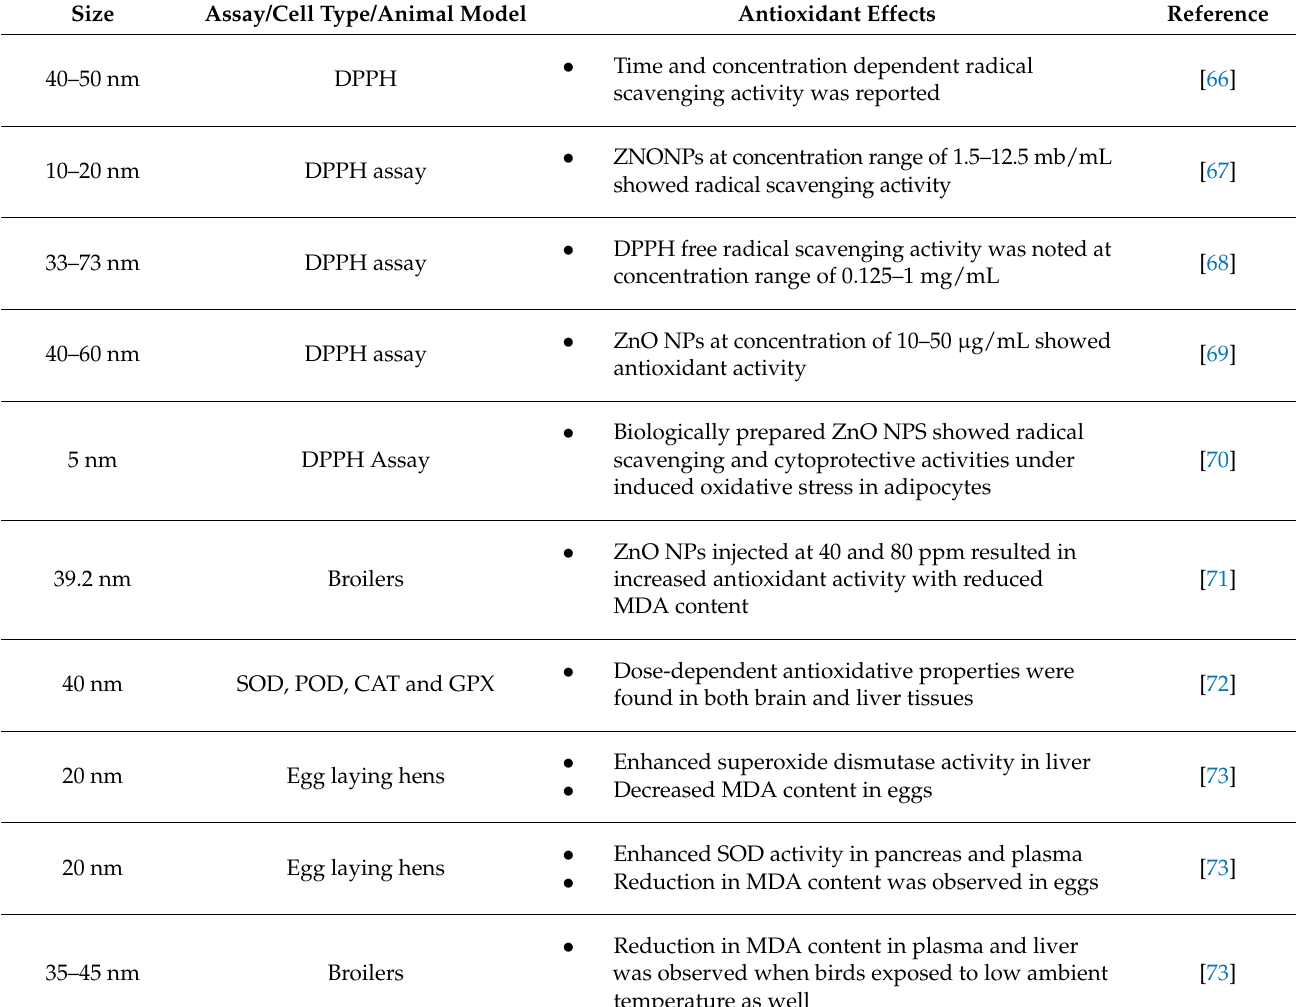
Table 1. Different Antioxidant enzymatic activities in various cells and organism on exposure to ZnO